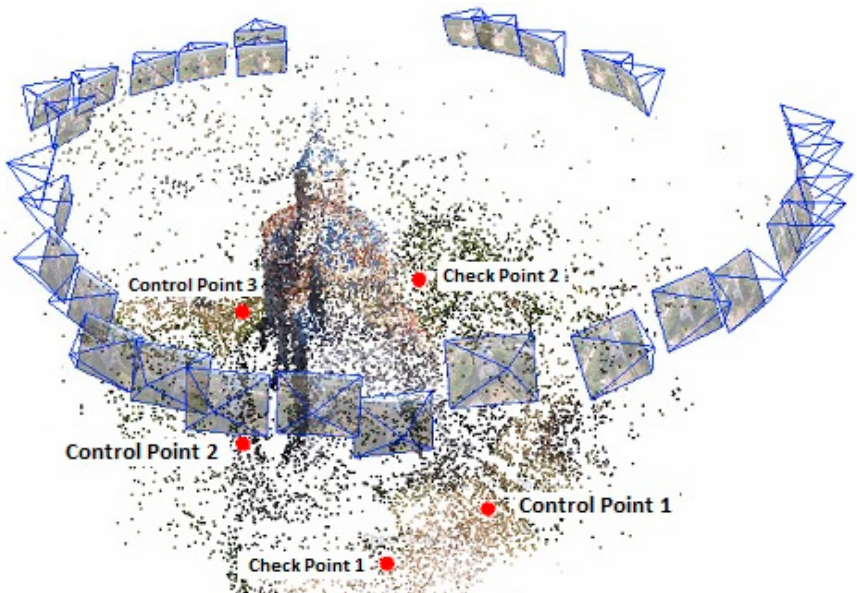
Figure 17. The elements resulted after the bundle adjustment process: cameras positions and orientations and GCPs and CPs positions.